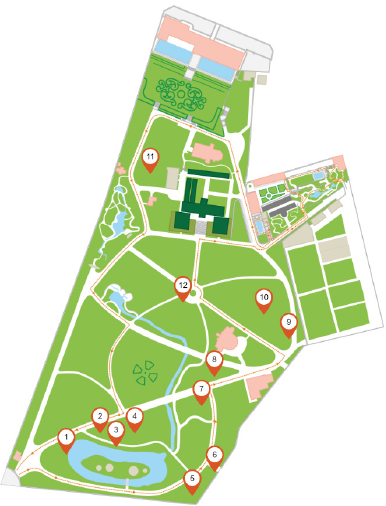
Figure 9. Map measurement sites where the numbers from 1 to 11 represents the labels for the measurement sites.